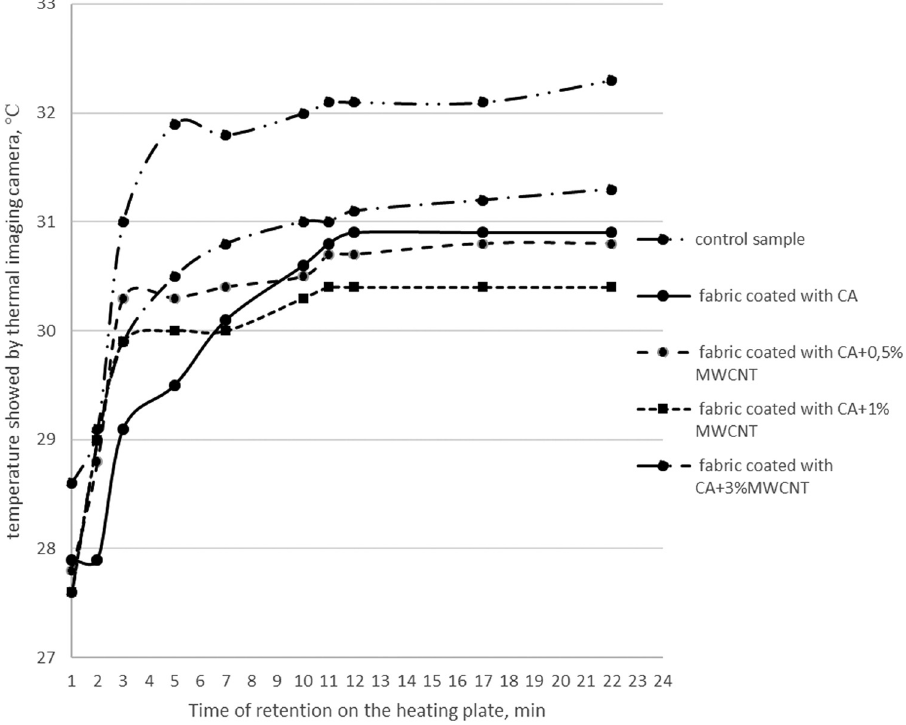
Figure 8: Dynamic thermal behavior of textile samples coated with pure CA and composites of CA with MWCNT, during heating.